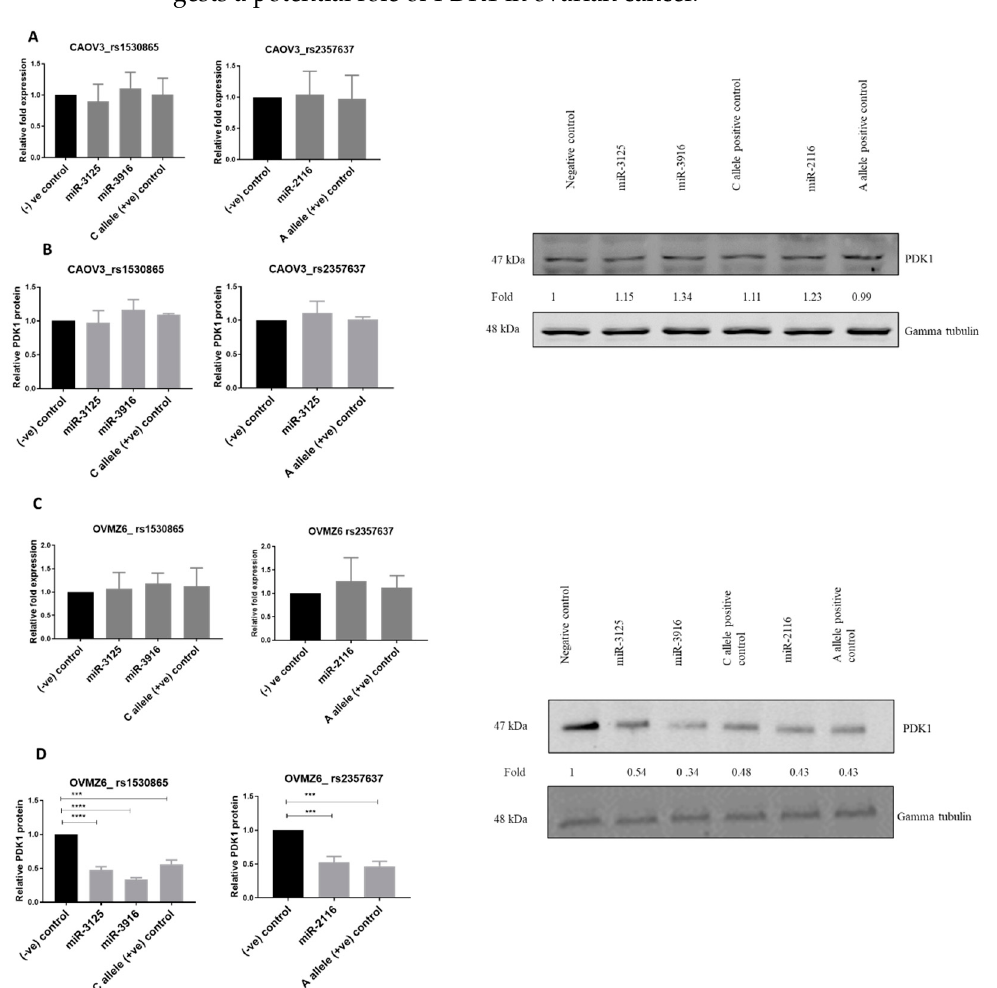
(Supplementary Figure S6). This up-regulation of PDK1 in ovarian tumour tissues sug- gests a potential role of PDK1 in ovarian cancer.